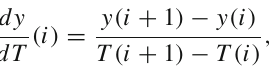
to obtain the HMI and EoP. We compute the HMI and EoP for two different values of l and l (cid:3) i.e. ( l = 0 . 05 , l (cid:3) = 0 . 01 ) and ( l = 0 . 05 , l (cid:3) = 0 . 005 ) . In Figs. 8 and 9, we plot the HMI